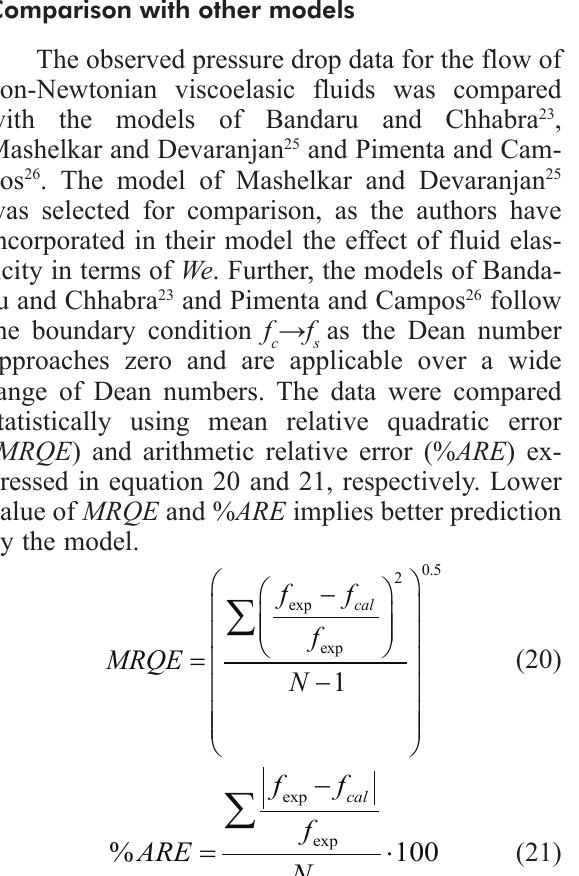
Fig. 5 Functional relationship between (( f c /f s ) ve /( f c /f s ) n )-1 and We